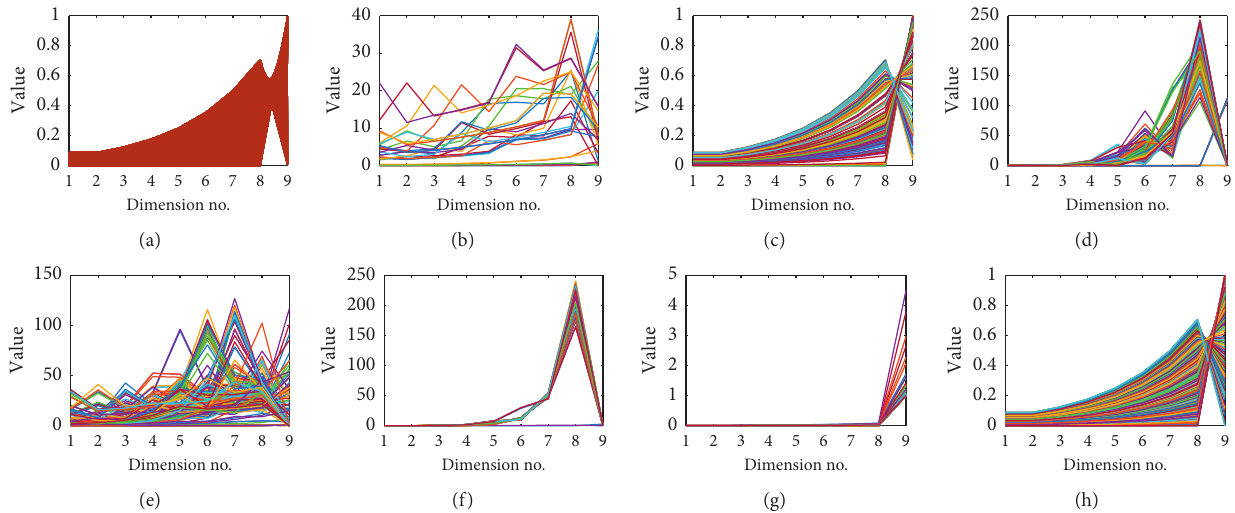
Figure 3: For 9-objective MaF6, its true PF and output populations of seven algorithms in parallel coordinate: (a) true PF of MaF6; (b) RVEA on MaF6; (c) NSGA-III on MaF6; (d) VaEA on MaF6; (e) MOEA/DD on MaF6; (f) SPEA2+SDE on MaF6; (g) MOEA/D-AM2M on MaF6; (h) ASES on MaF6.